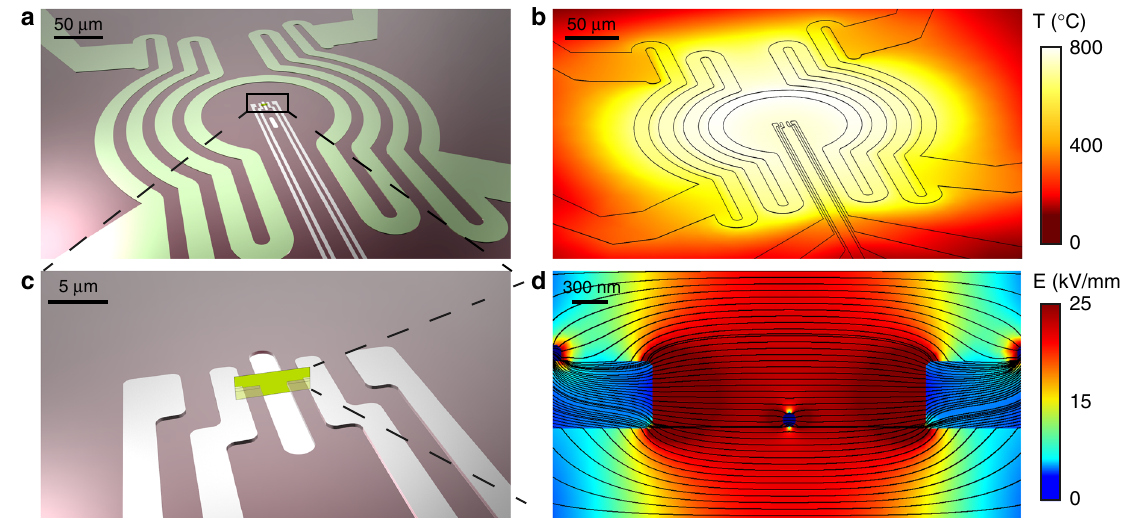
Fig. 1 Electro-thermal chip sample carrier for in situ transmission electron microscopy. a Schematics of the electro-thermal chip, including the set of biasing electrodes surrounded by the encapsulated microheater colored in green that is temperature controlled by Joule heating. b Corresponding simulated temperature distribution pro fi le generated by the microheater. c Magni fi ed view of the biasing wires region, showing a close-up of the 20 nm thick electron transparent window and the four surrounding biasing wires. The green plane represents the cross-section where the electric fi eld magnitude is plotted. d Finite element simulation of local electric fi eld magnitude and the electric fi eld lines over the cross-sectional plane indicated in c . A nanoparticle was placed in the window area between the electrodes for